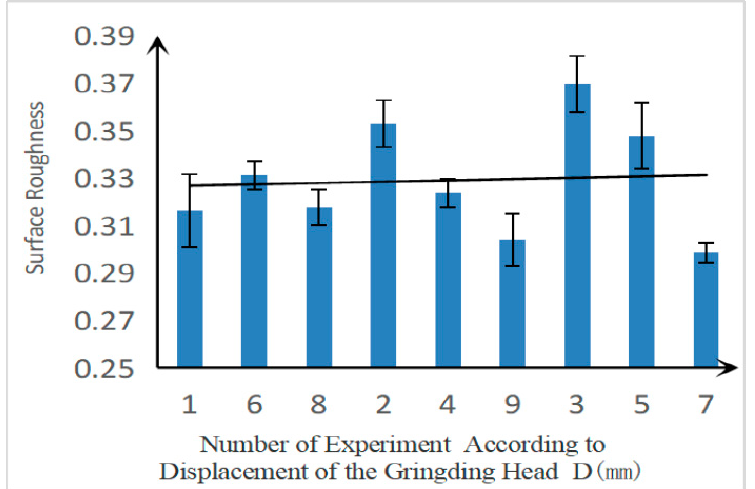
Figure 11. Relationship between the surface roughness and the amount of downward movement of the grinding head.